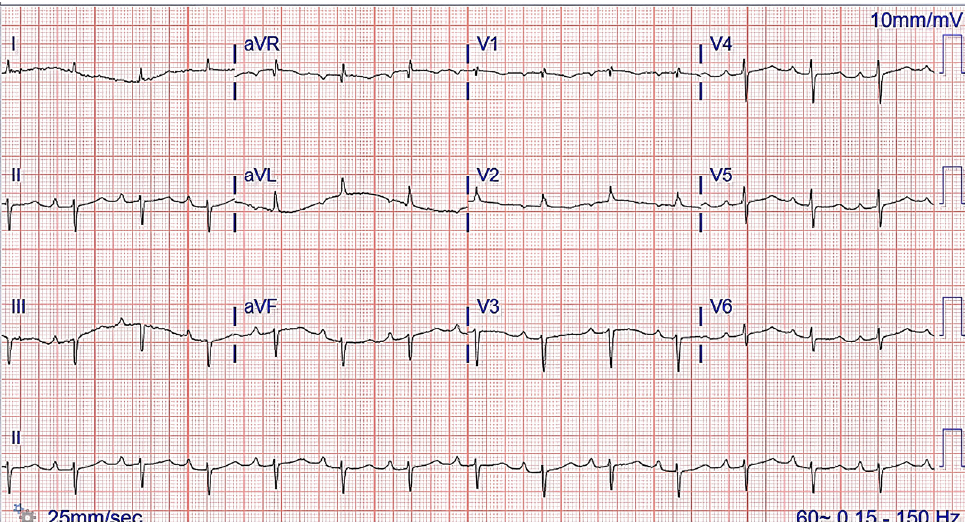
Figure 1. ECG showing normal sinus rhythm with first-degree atrioventricular block and left axis deviation.